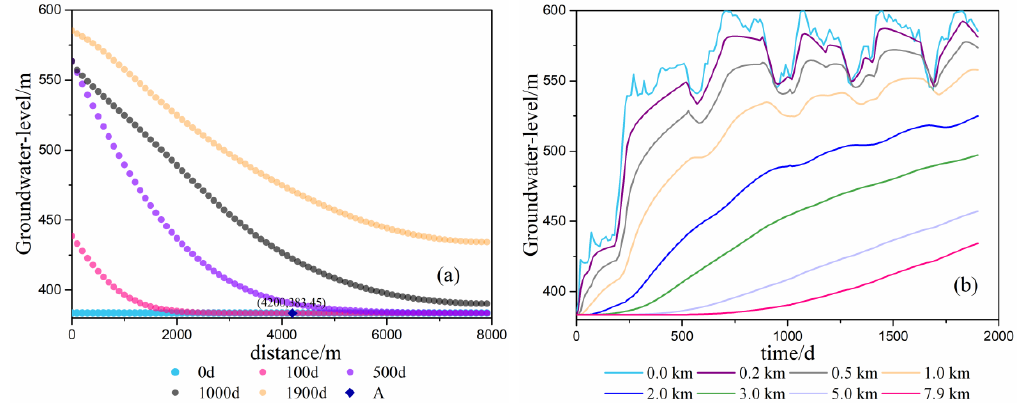
Figure 6. Groundwater-level fluctuation curves at different points in study area ( a ) and groundwater- Groundwater-level fluctuation curves at di ff erent points in study area ( a ) and level duration curves ( b ) in the unconfined aquifer. groundwater-level duration curves ( b ) in the unconfined